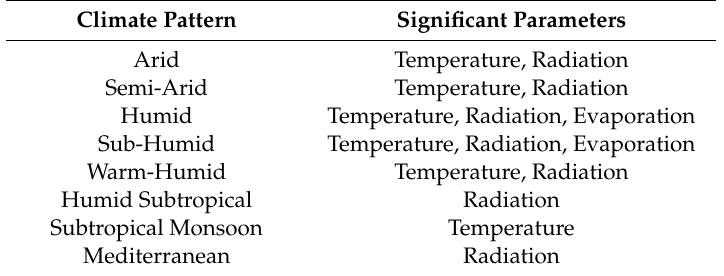
Table 1. Significant parameters for different climate patterns to estimate evapotranspiration